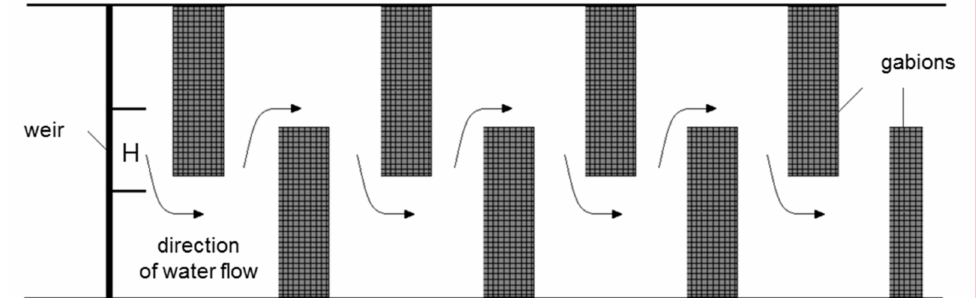
Figure 7. Crosswise arrangement of the treatment system for hypolimnetic water using reactive materials. H: outlet of the hypolimnion withdrawal pipe.